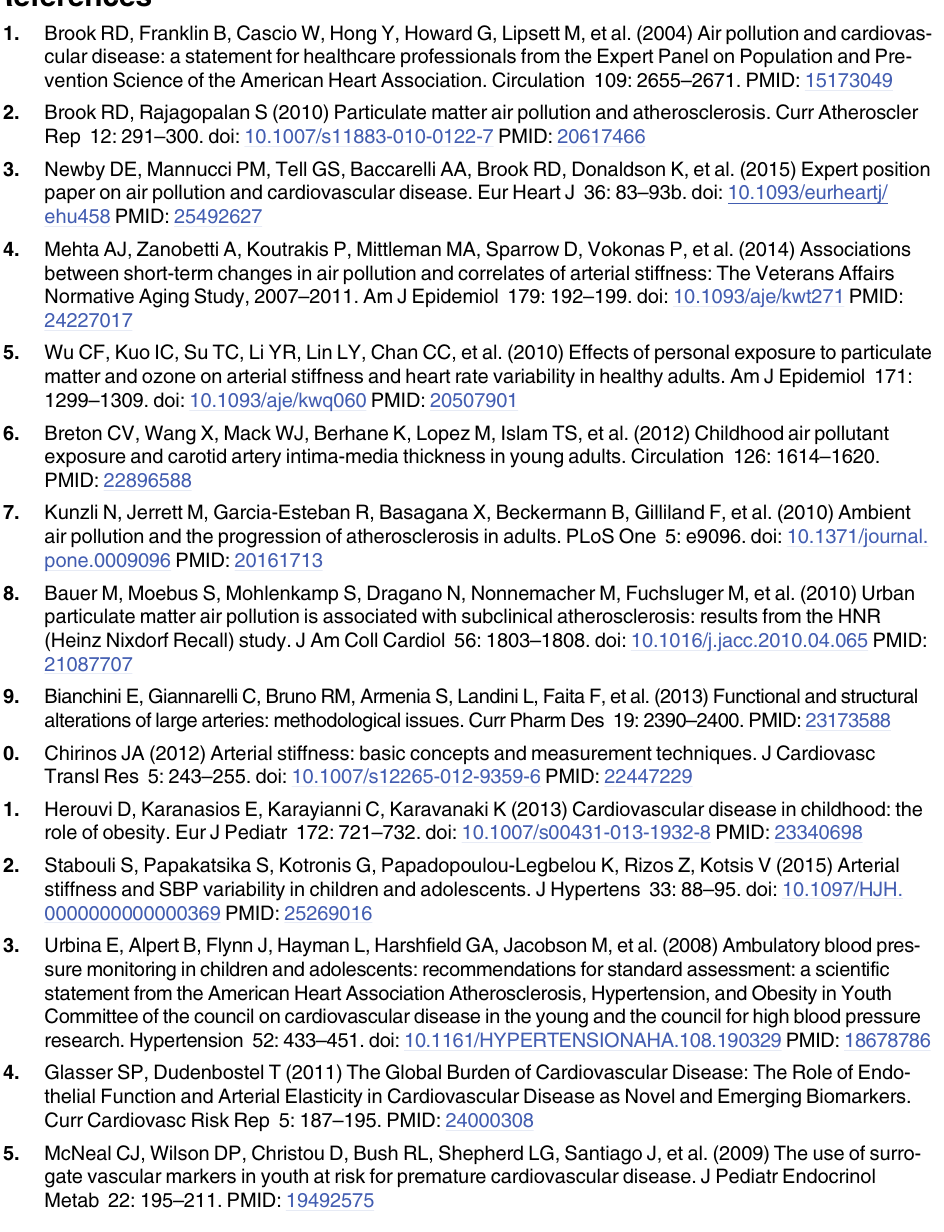
S10 Table. The association between prenatal air pollutant exposures and C-beta restricted to air pollution assignments within 5 km of a